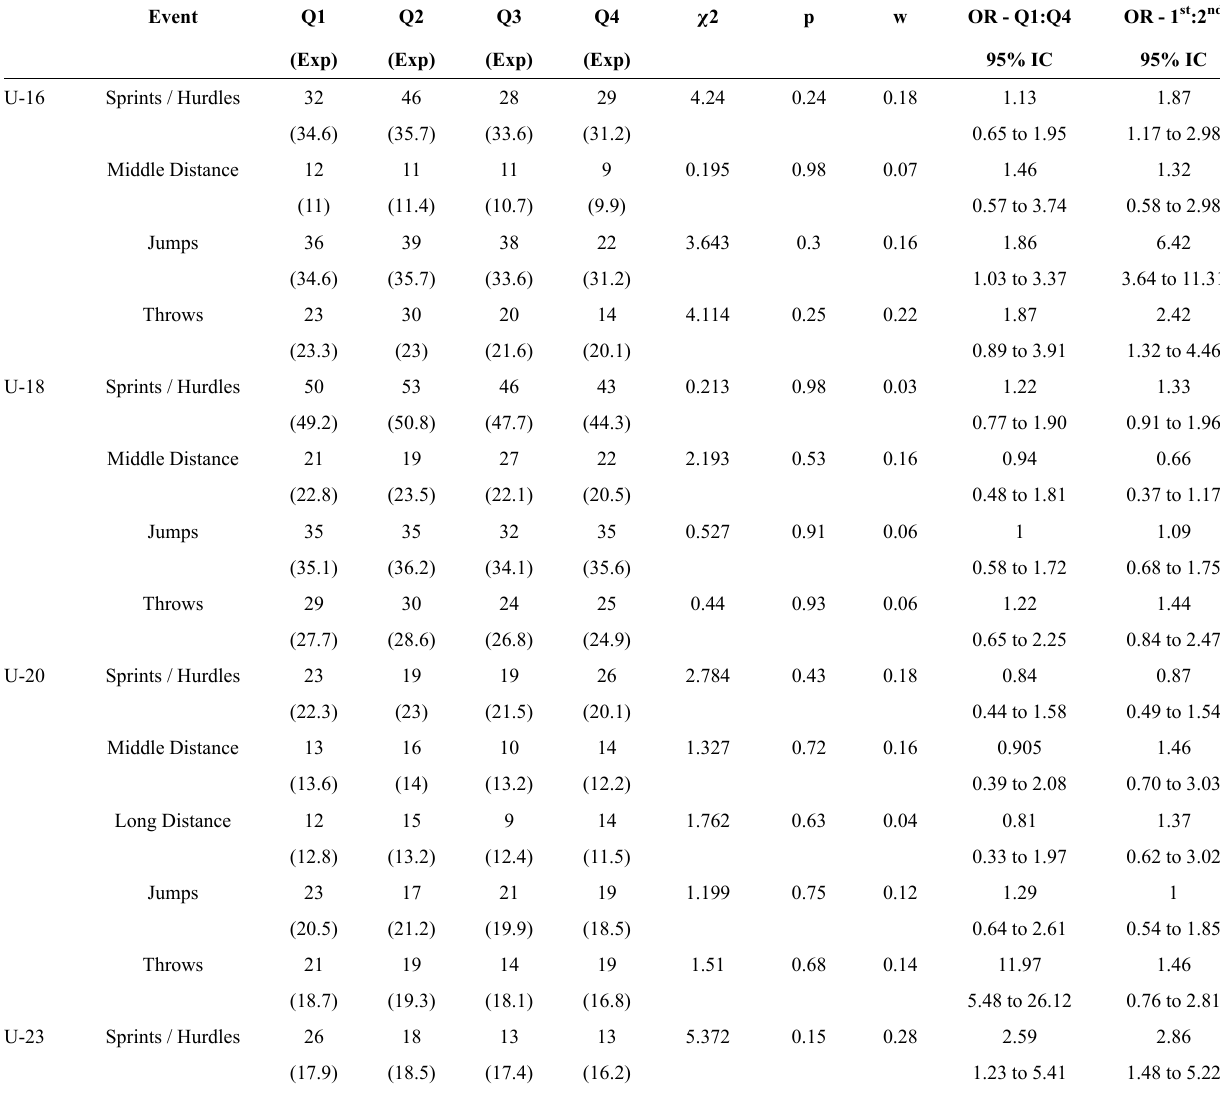
Table 2 - Quarter of birth distribution of female Brazilian Track and field athletes’ by age category and